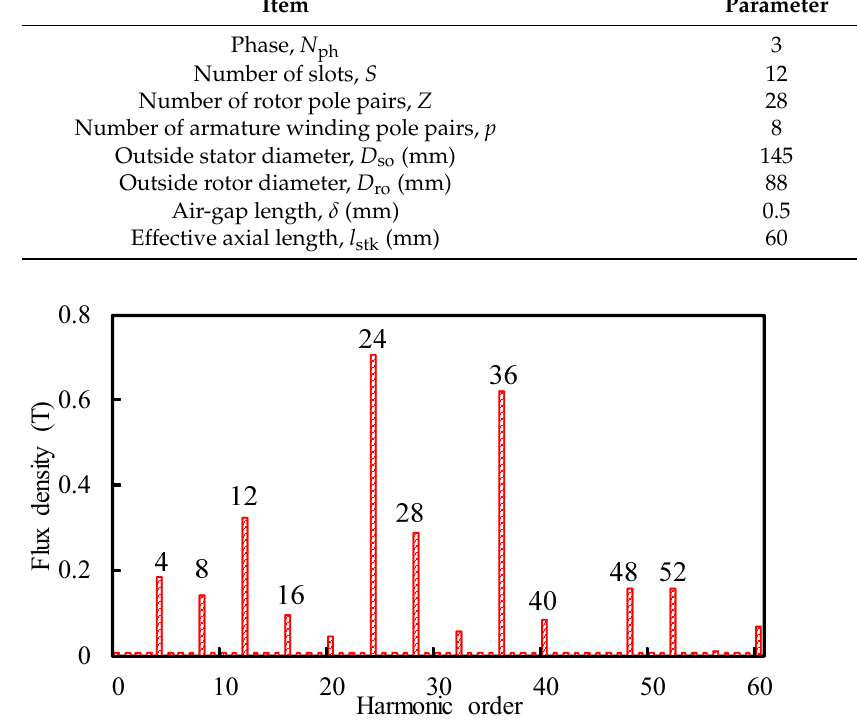
Table 1. Machine parameters. Item Parameter Phase, N ph Number of slots, S Number of rotor pole pairs, Z